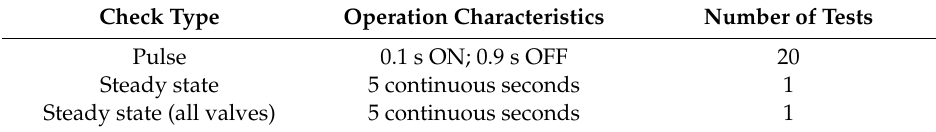
Table 4. Thruster assembly operation test sequence for the entire propulsion system.